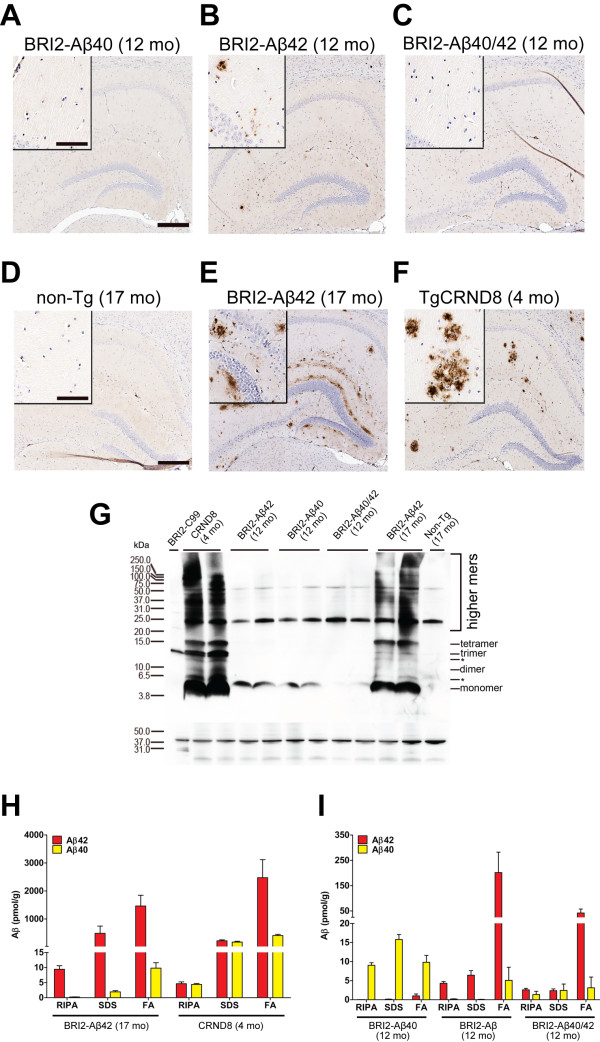
Aβ pathology in BRI2-Aβ transgenic mice. Images of the hippocampal region immunostained with an anti-Aβ1-16 antibody (A-C) 12-month-old BRI2-Aβ, (D) 17-month-old non-Tg, (E) 17-month-old BRI2-Aβ1-42 and (F) 4-month-old APP CRND8 mice. (G) Representative 82E1 immunoblots of 4-month-old CRND8 mice and 17-month-old BRI2-Aβ1-42 mice show increased presence of Aβ oligomers (di/tri/tetrameric and higher molecular weight species) as compared to younger 12-month-old BRI2-Aβ and 17-month-old non-Tg mice. The first, control lane includes H4 cell lysate expressing BRI2-C99 fusion protein. A band between 10 and 15 kDa represents C99 peptide. Molecular weight markers are indicated on the left (kD). The lower panel represents the 82E1 blot re-probed with anti-β-actin antibody to depict loading amount (* Bands not characterized). (H-I) RIPA soluble and insoluble Aβ levels in the brains of BRI2-Aβ and CRND8 mice were measured by Aβ ELISA after sequential extraction using RIPA, SDS, and FA (n = 10-15 per genotype). Scale bars (A, D): 250μm, inserts-80μm. Error bars represent s.e.m. For brevity and clarity of presentation, we used shorter labels of BRI2-Aβ lines (BRI2-Aβ40; BRI2-Aβ42; BRI2-Aβ40/42) in the panels of all figures.